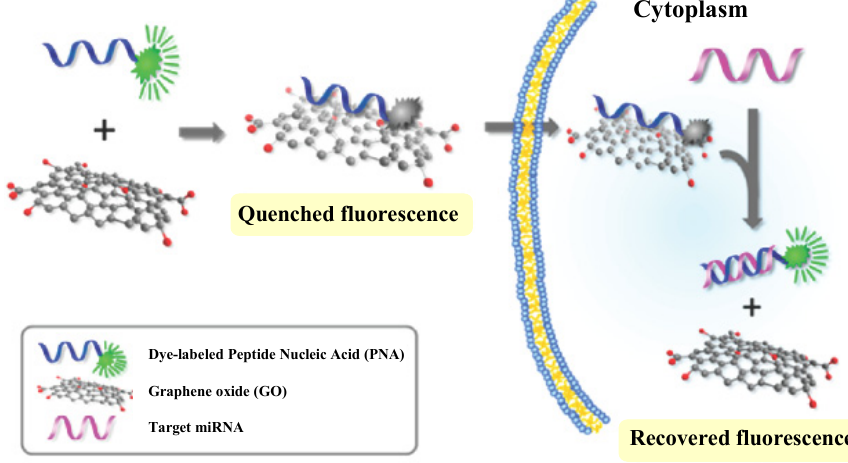
Figure 12. Scheme of strategy for a miRNA sensor based on NGO and PNA. Reprinted with permission from [67]. Copyright 2013 American Chemical